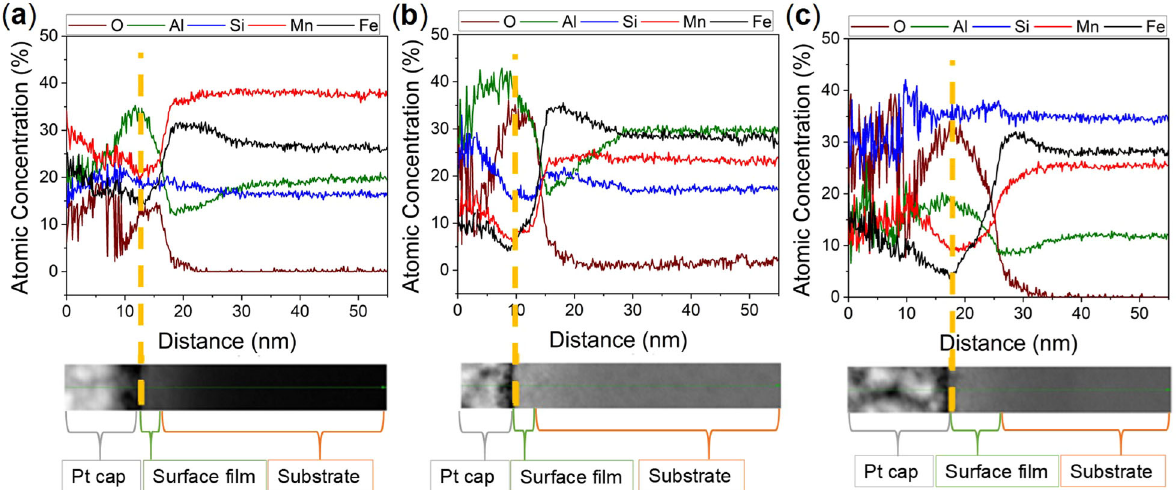
Fig. 9 STEM – EDXS line pro fi les and STEM images post 24 h immersion of the phases in the AlFeMnSi alloy in 0.6 M NaCl. STEM – EDXS line pro fi le (and corresponding STEM image) showing composition of the surface fi lm upon the three phases that comprise the AlFeMnSi alloy microstructure (as noted in Fig. 1d) after 24 h immersion in 0.6 M NaCl, a Phase I, b Phase II, and c Phase III. Specimens were prepared from site speci fi c focused ion beam (FIB)